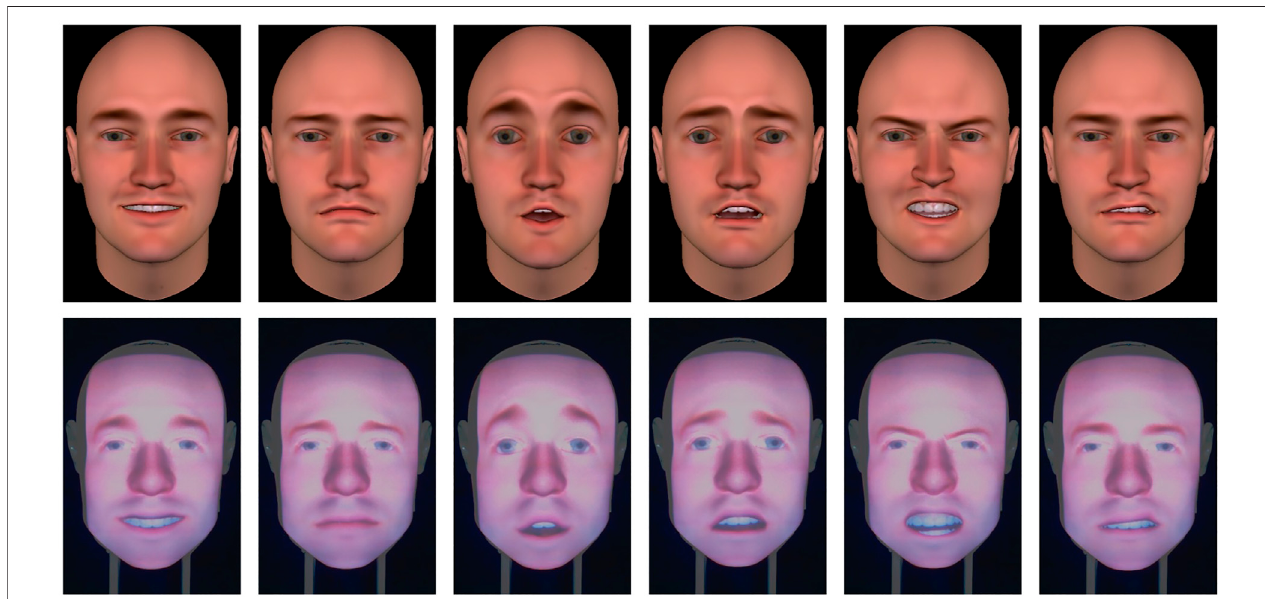
FIGURE3| Facialexpressionsofthesixbasicemotions.Fromlefttoright:happiness,sadness,surprise,fear,angeranddisgust.Fromtoptobottom:virtualagent, Furhat robot.